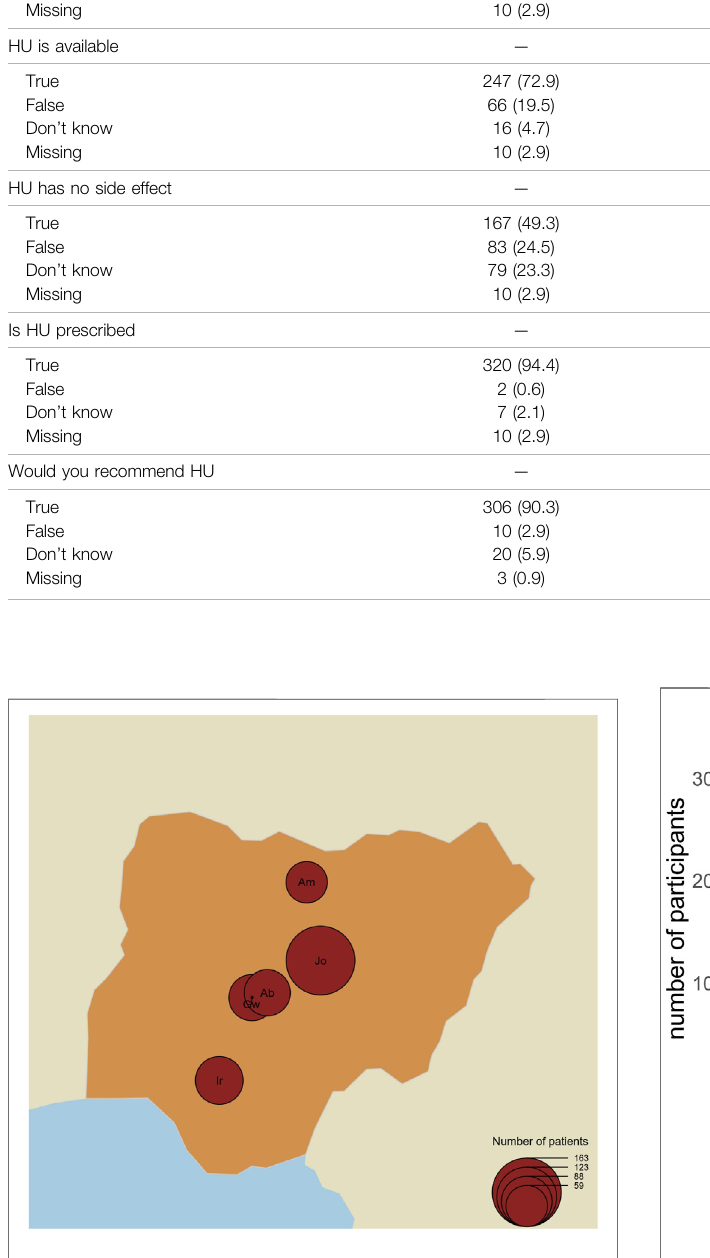
FIGURE 1 | Map of Nigeria showing the number of patients per centre and locations of the study centre. The map shows the location of the study centres and the size (black circles) of patients recruited for the study per centre. Gw = University of Abuja Teaching Hospital, Gwagwalada, Jo =